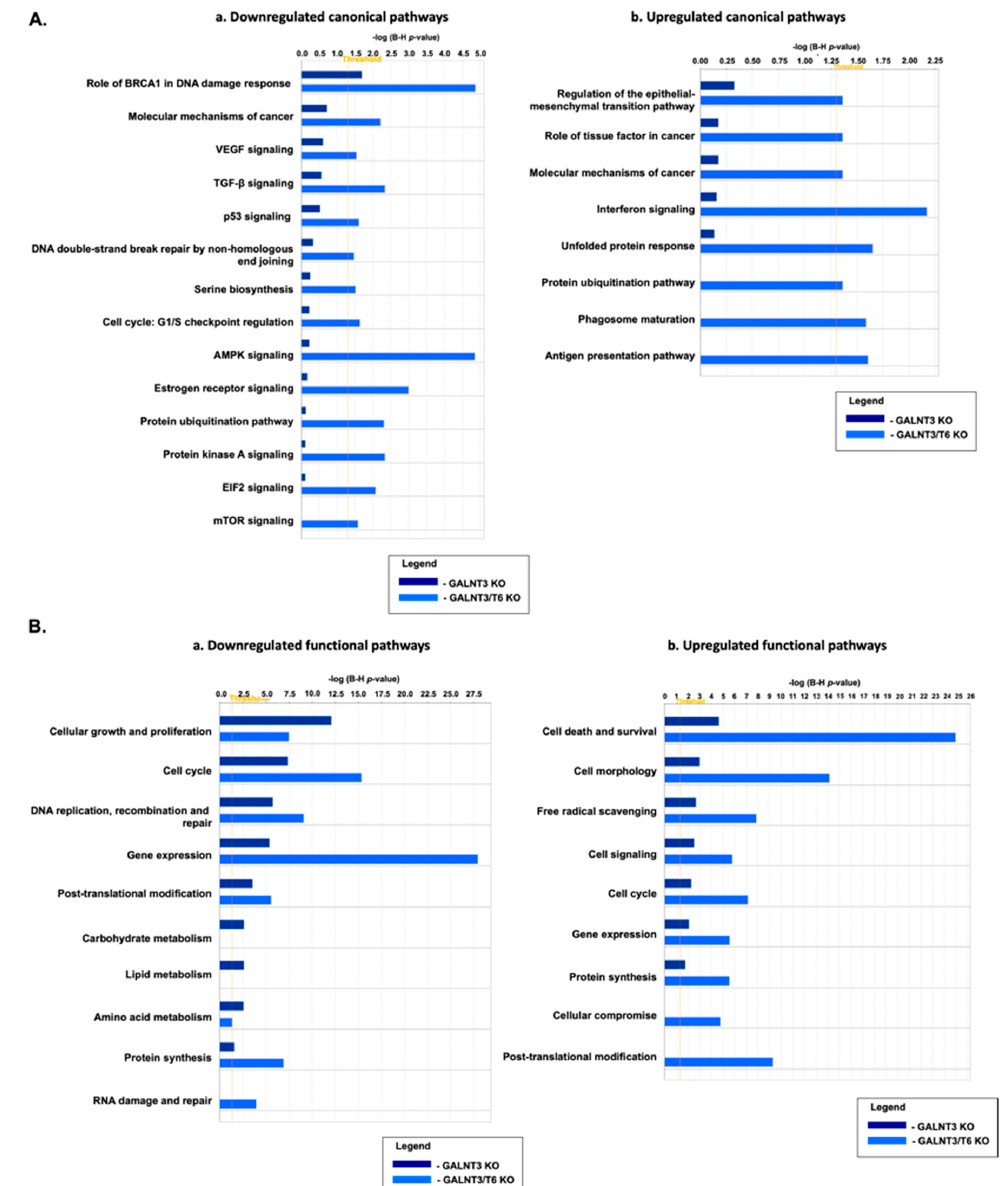
Figure 4. Comparative canonical and functional pathway analysis for a dataset of differentially expressed genes ( ≥ 1.5 ‐ fold; p < 0.05) following GALNT3 KO and GALNT3/T6 KO in A2780s cells. ( A ) ( a ) Comparison analysis of downregulated canonical pathways; ( b ) comparison analysis of upregulated canonical pathways. Top functions that meet a Holm–Bonferroni multiple testing correction p ‐ value of 0.05 are displayed. ( B ) ( a ) Comparison analysis of downregulated functional pathways; ( b ) comparison analysis of upregulated functional pathways. Top functions that meet a Holm–Bonferroni multiple testing correction p ‐ value of 0.05 are displayed. The bar ‐ charts represent significance of gene enrichment for any given pathway with scores of 2 < z ‐ score < − 2.